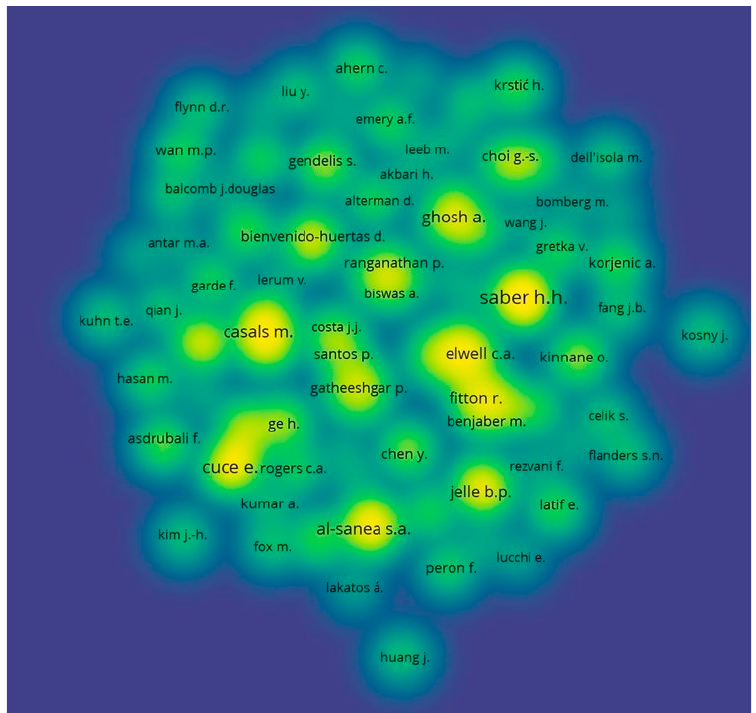
Figure 4. Density visualization of the authors with at least two publications or more on the topic “ thermal transmittance assessment of building* ” (source: authors’ elaboration using VOSviewer, based on Scopus data).